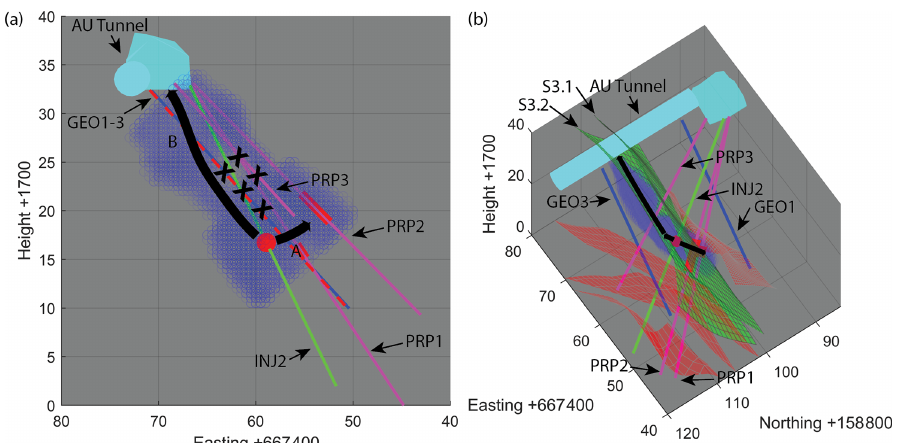
Figure 11. Interpretation of the tracer flow path reconstruction. (a) Side view. The tracer indicated by the black arrows passes through the GEO plane (red/blue) at two locations, labeled A and B. (b) Reconstructed flow path along with the shear zones S3 (green) and S1 (red) in the experiment volume. The PRP intervals are indicated in